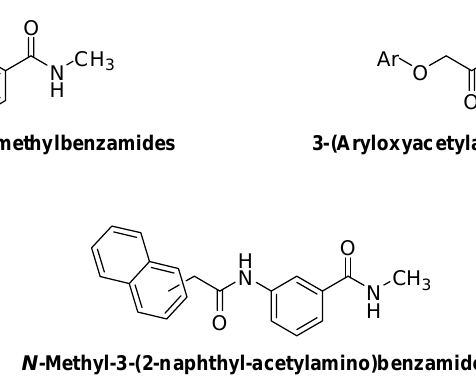
Figure 1. The general structures of 3-(arylacetylamino)- N -methylbenzamides, 3-(aryloxyacetylamino)- N -methylbenzamides and N -methyl-3-(2-naphthyl-acetylamino)- benzamides.